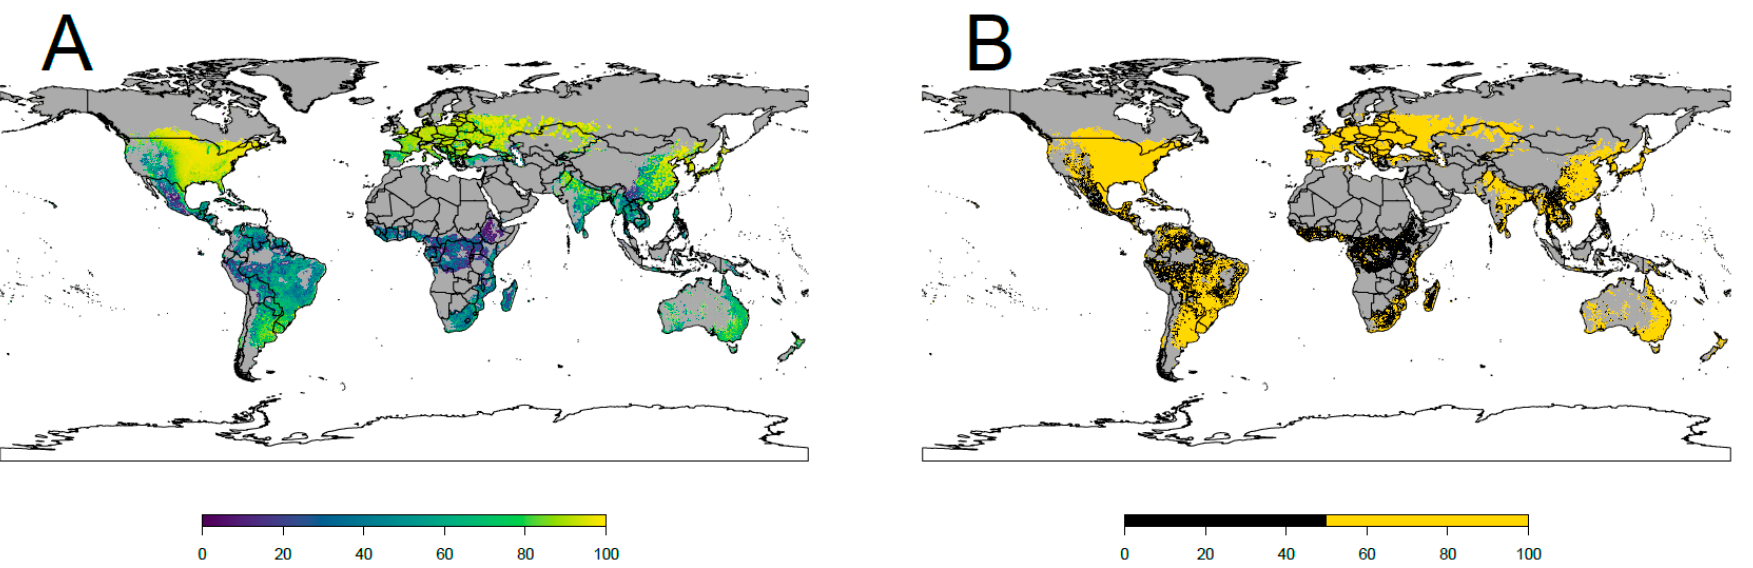
Figure 2. Distribution maps of the Japanese beetle, estimated under current conditions derived from INLA SPDE. ( A ) yellow–blue scale indicates higher–lower occurrence probability values, respectively, ( B ) areas of predicted species occurrence estimated using a threshold value of 50.3 (threshold values estimated by maximizing TSS), presence shown in orange, while absence shown in black. Areas of uncertain prediction identified by mMESS, and those with DD values below the threshold of 711, are shown in grey.